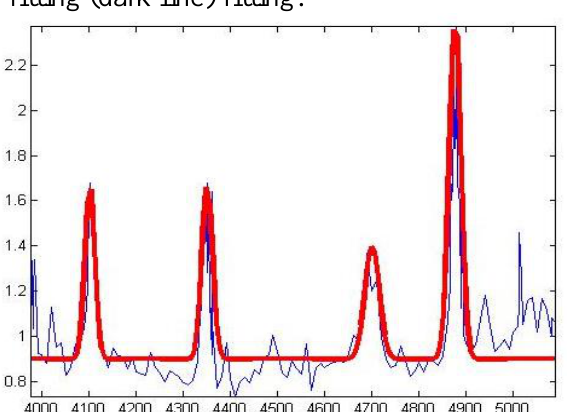
Fig. 3: Real spectroscopic data of EX DRA and its smoothed fitting